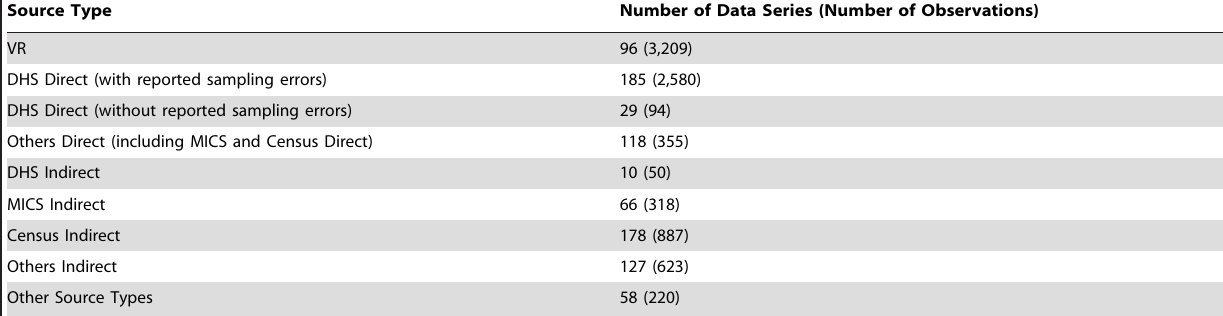
Source Type Number of Data Series (Number of